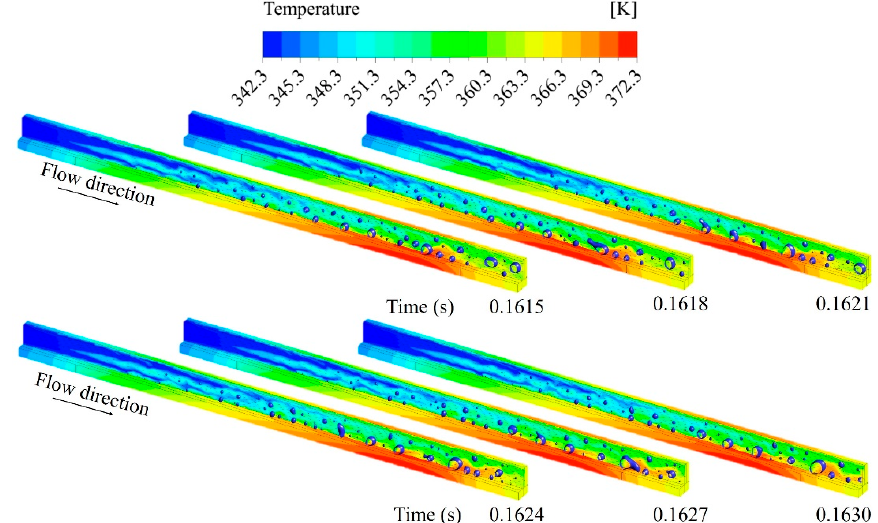
Figure 11. Transient temperature distribution and two-phase flow pattern at G = 700 kg / (m 2 · s) for the cross-section of 0.2 × 0.5 mm.